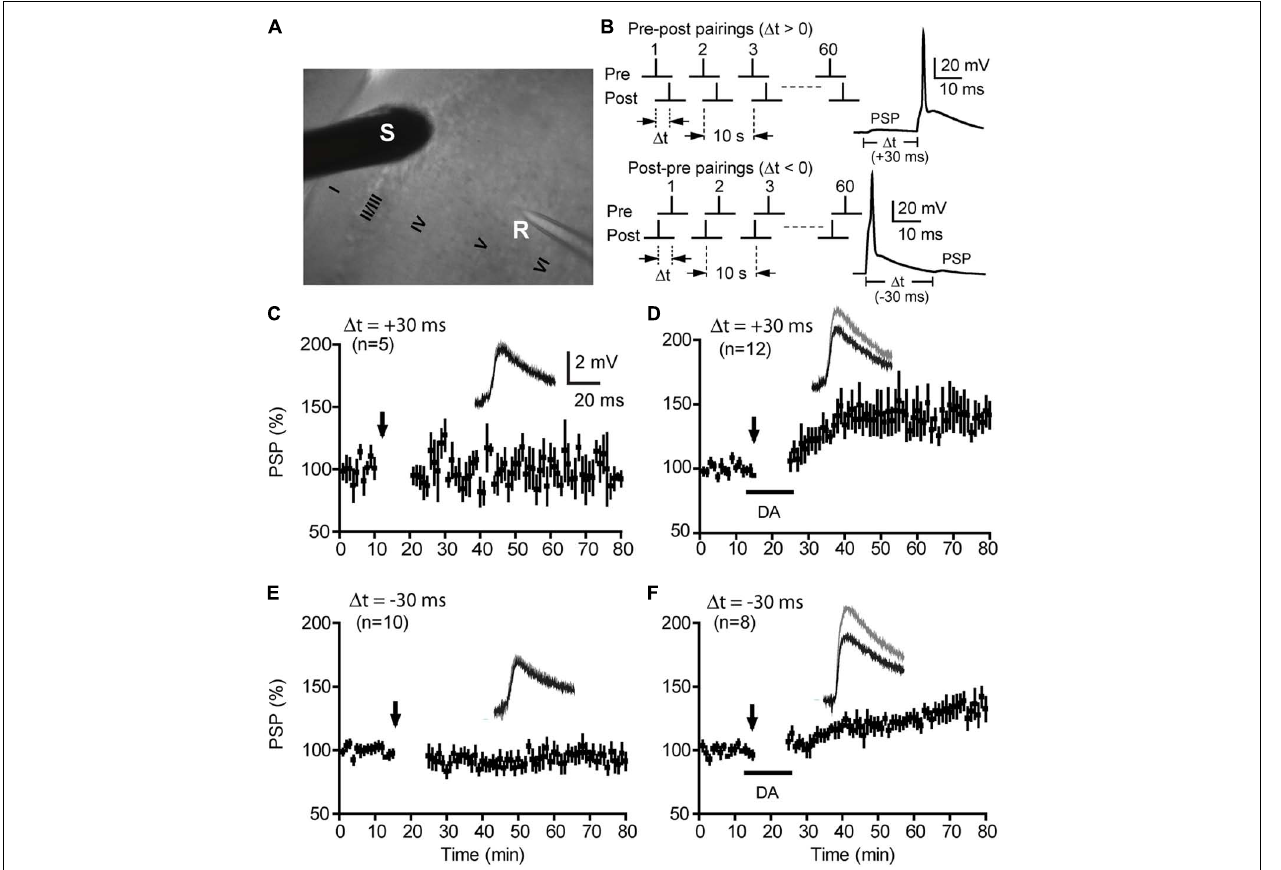
FIGURE 1 | Dopamine enables t-LTP over a 60-ms timing window under intact GABAergic conditions. (A) A DIC image of a mouse mPFC coronal slice showing recording (R) and stimulation (S) sites. Cortical layers are also marked. (B) t-LTP induction protocols: paired presynaptic PSPs and postsynaptic APs with positive (top) and negative (bottom) Δ t, delivered at 0.1 Hz for 10 min (60 pairs). Representative PSP-AP and AP-PSP responses during paired stimuli are shown. (C,E) Lack of t-LTP induction at Δ t = + 30 ms